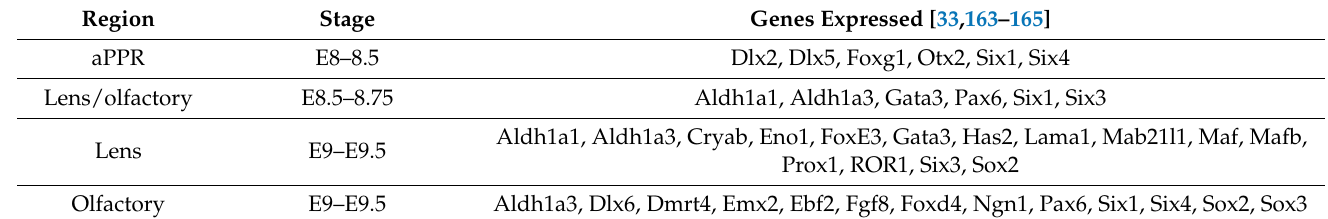
Table 2. Marker genes expressed during the formation of lens and olfactory placodes.